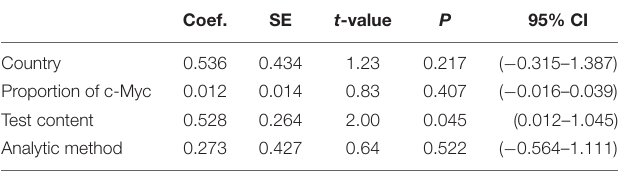
TABLE 4 | The results of Meta-regression.